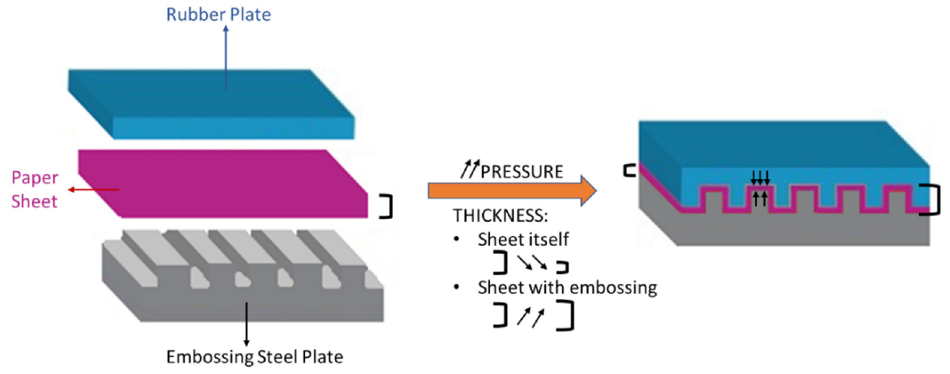
Figure 1. Scheme of the embossing process with pressure action effects .